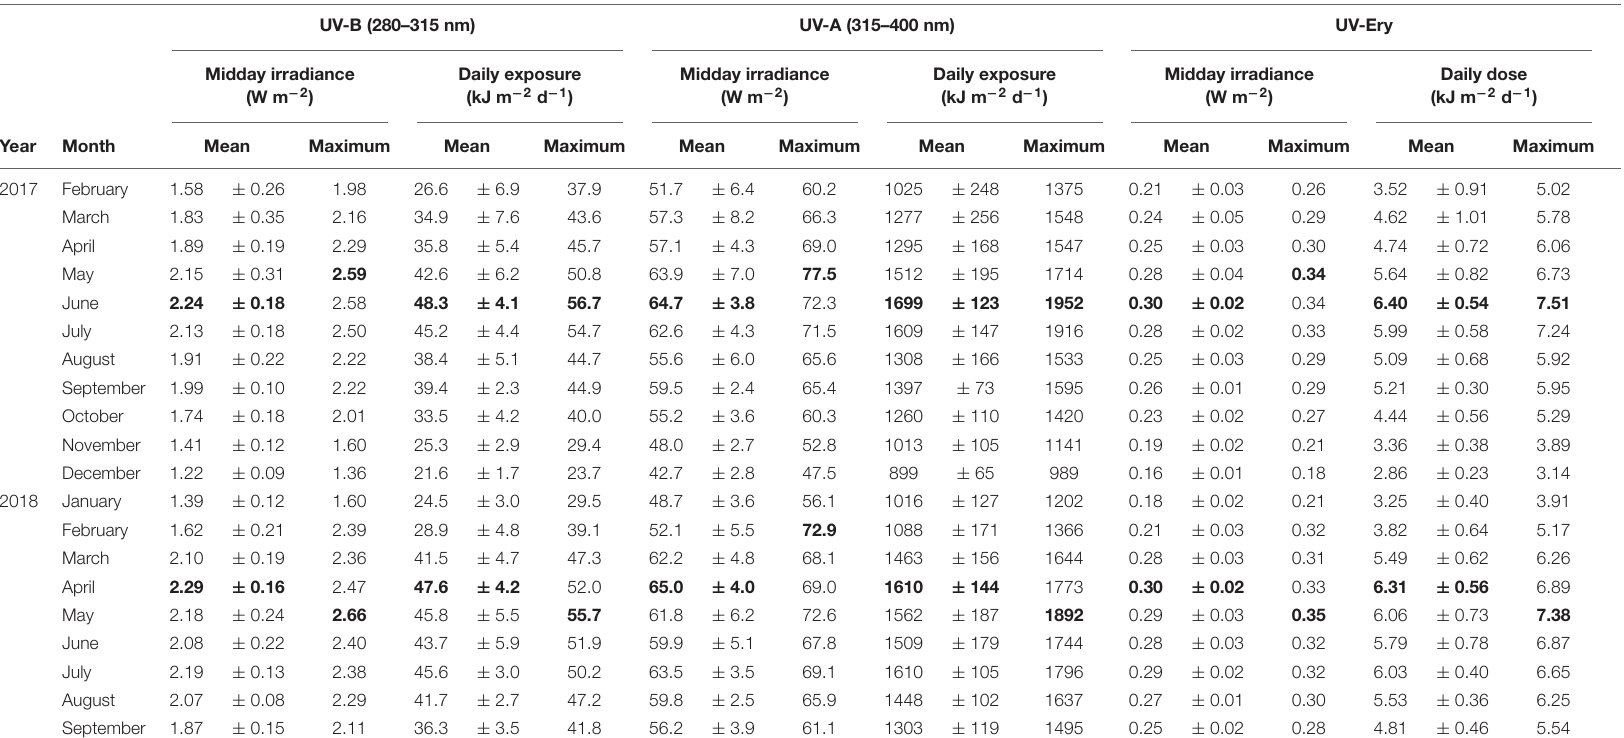
TABLE 1 | Atmospheric UV-B (280–315 nm), UV-A (315–400 nm), and erythemally weighted UV (UV-Ery) conditions at KAUST (22.304639 ◦ N, 39.102167 ◦ E) between February 2017 and September